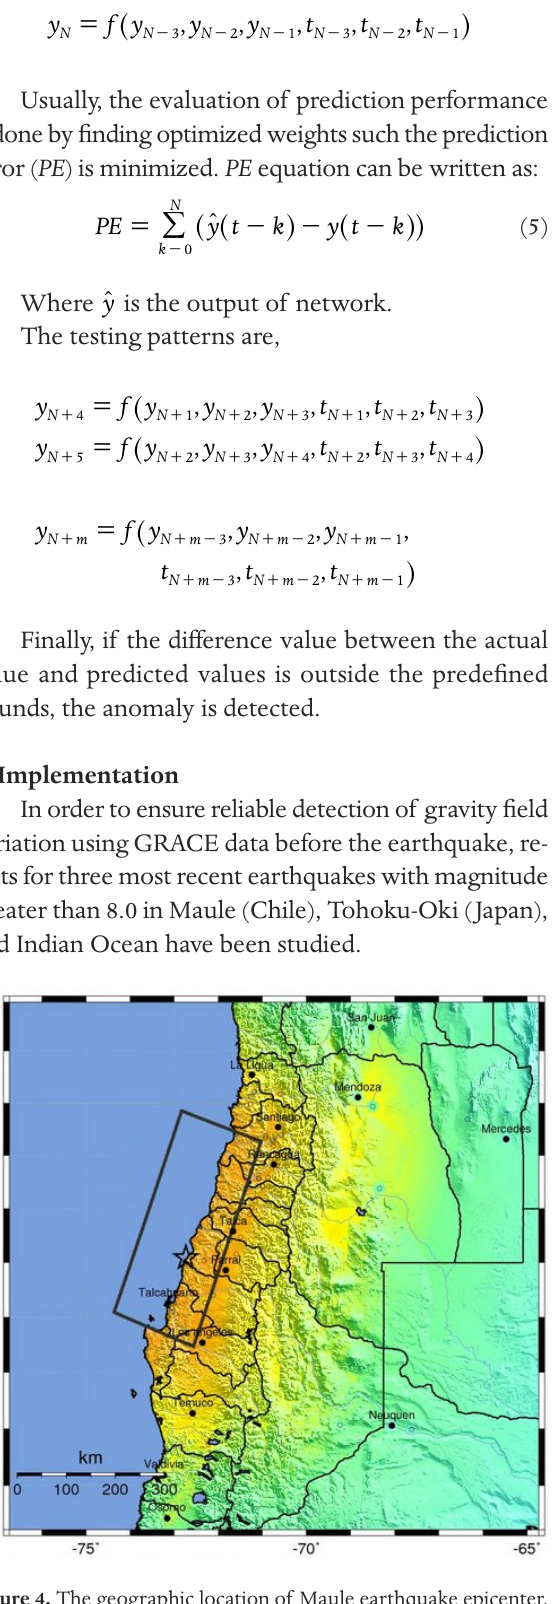
Figure 4. The geographic location of Maule earthquake epicenter. A vacant star represents epicenter. (Figure taken from: http://earth